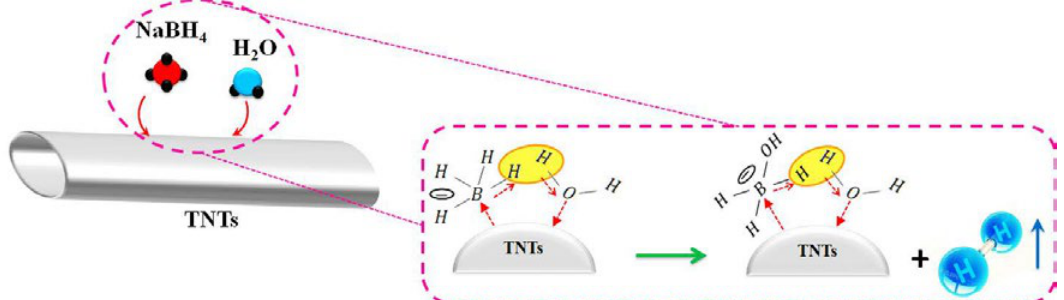
Fig. 7. Proposed mechanism for the catalytic hydrolysis of NaBH